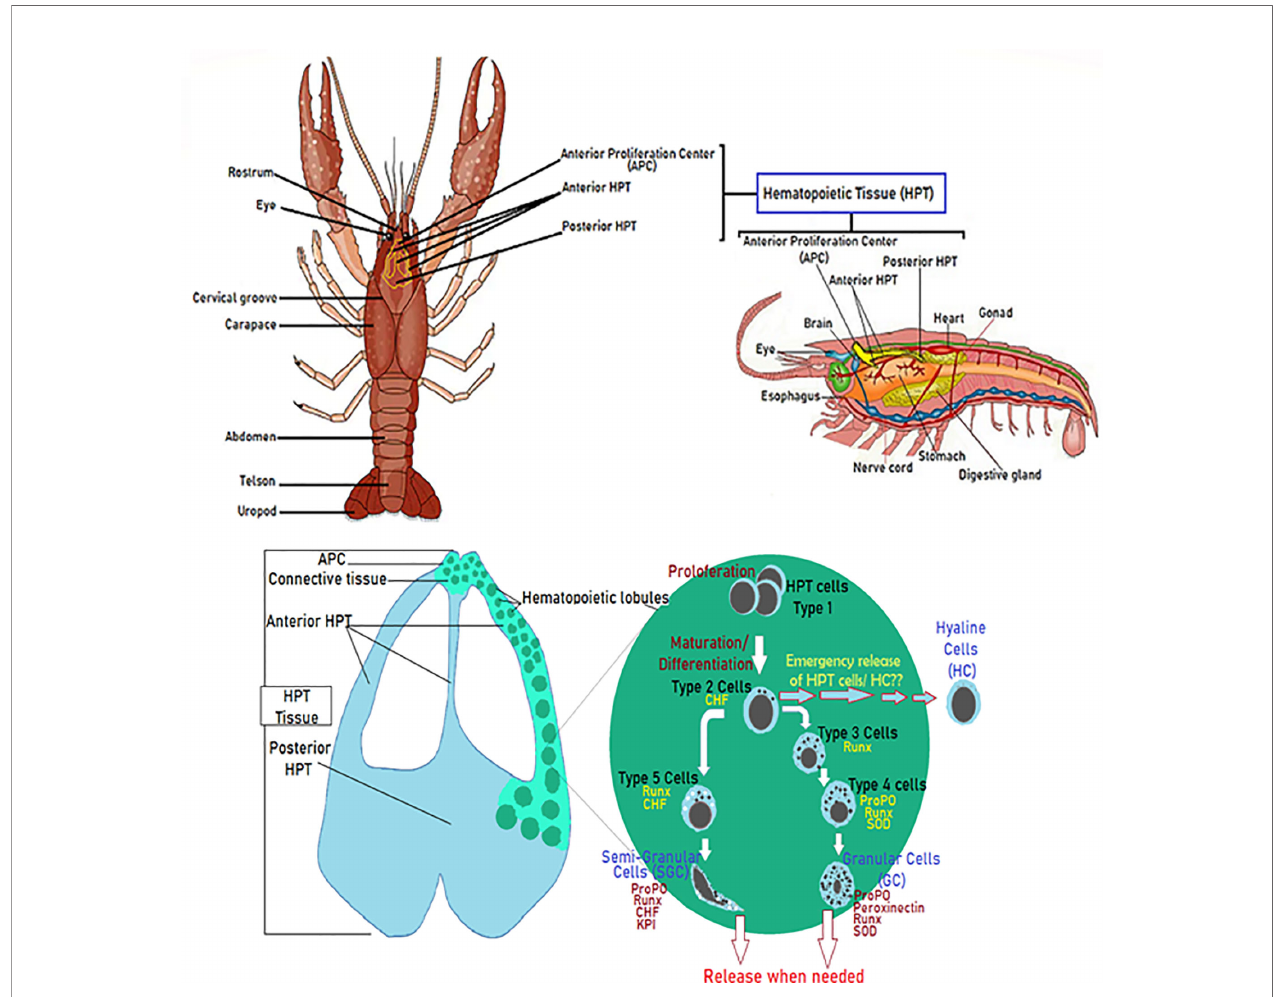
FIGURE 2 | Diagram of the hematopoietic tissue (HPT) illustrating the hematopoiesis ’ mechanistic steps. Schematic localization and presentation of the different parts of the HPT and the hematopoietic lobules illustrating the different phases of hemocyte production and how different cell types (Type I-V) acquire their speci fi c molecular markers (47, 53, 75, 80 –